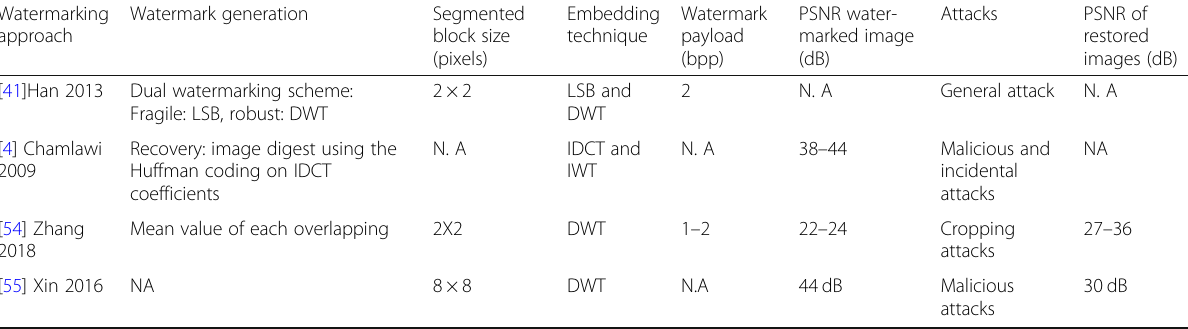
Table 3 Summarisation of some self-embedding fragile watermarking methods in the transform domain Watermarking